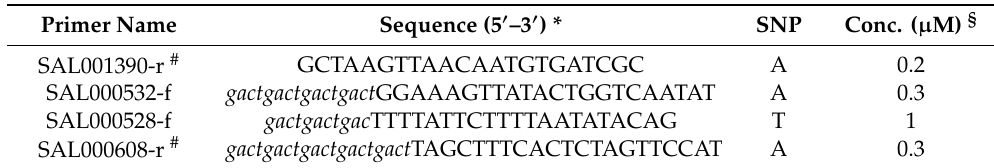
Table 2. Single nucleotide polymorphism (SNP) primers designed to direct strain typing for Lactobacillus acidophilus